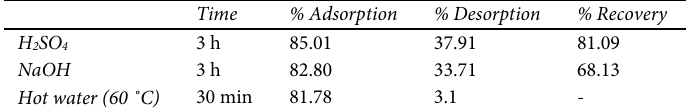
Table 1. Results of regeneration and recovery of β -CD modified magnetic nanoparticles. Table. 4. Results of desorption and recovery of β-CD modified magnetic nanoparticles